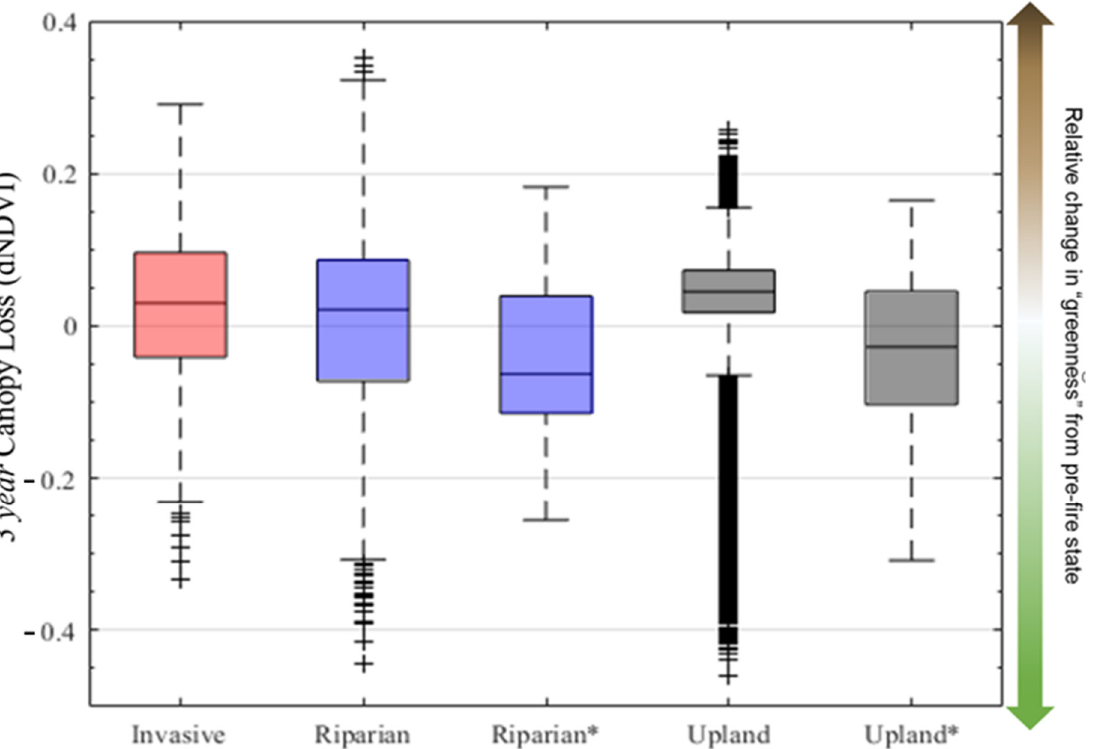
图 4 Figure 4. Canopy loss proxied by differenced Normalized Difference Vegetation Index (dNDVI) 3 years post-fire for each vegetation class. Control fire vegetation classes (no invasive species) are denoted by *. Box and whisker plots indicate the median, 25th, and 75th percentiles. The whiskers extend to the most extreme data points not considered outliers, and the outliers are denoted by